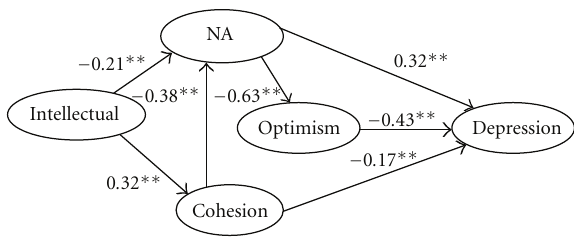
Figure 1: Path analysis of depression in adolescents. Note: the figure represented B , ∗∗ represented significance level ( P < .